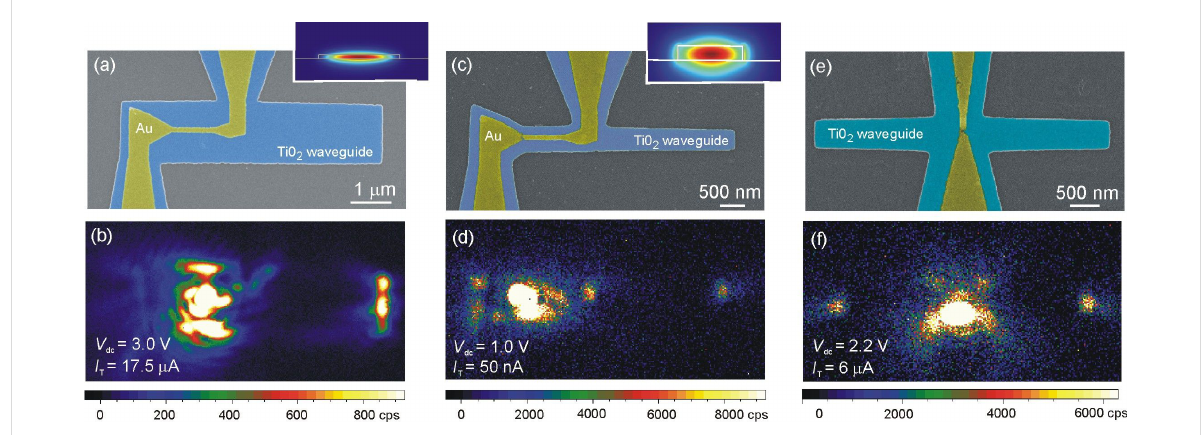
Figure 6: (a, c, e) Colorized scanning electron micrographs of the electron-fed optical antennas integrated in various waveguiding geometries. The yellow and blue hues show the Au and TiO 2 materials, respectively, and the glass substrate appears in gray. The TiO 2 waveguides are 1.5 μ m wide in (a) and 500 nm wide in (c) and (e). The Au electrodes are parallel to the waveguide axis in (a) and (c) while in (e), the orientation of the electrodes is perpendicular to the two symmetrical TiO 2 stripes. Insets: Calculated modal distribution of the electric field norm in the waveguides evaluated at 800 nm. (b, d, f) False-color CCD images of the distribution of light in the structure upon electrical biasing of the tunnel junction. The electrical condi- tions are given in the images and the integration time is 30 s for all frames. The color scale is saturated to enhance the contrast.